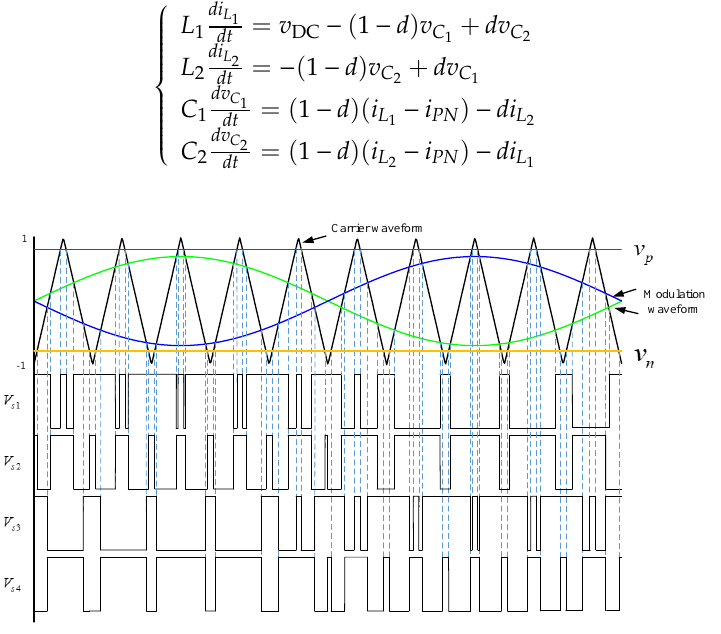
Figure 2. Conventional modulation strategy ( CMS) .